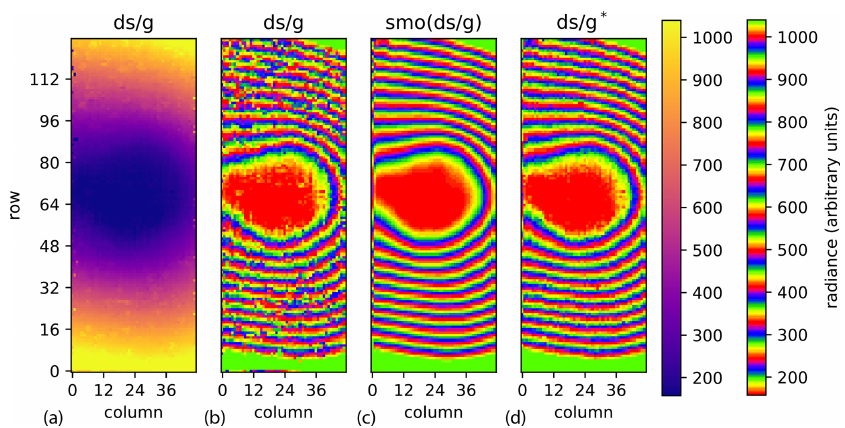
Figure B1. All: radiance offset at 964cm − 1 . Panel (a) : the raw unshaved deep-space spectrum divided by the uncorrected gain. Panel (b) : the same data, but with a color scale emphasizing irregularities. Panel (c) : the image smoothed by polynomial fits. Panel (d) : the raw unshaved spectrum divided by the corrected